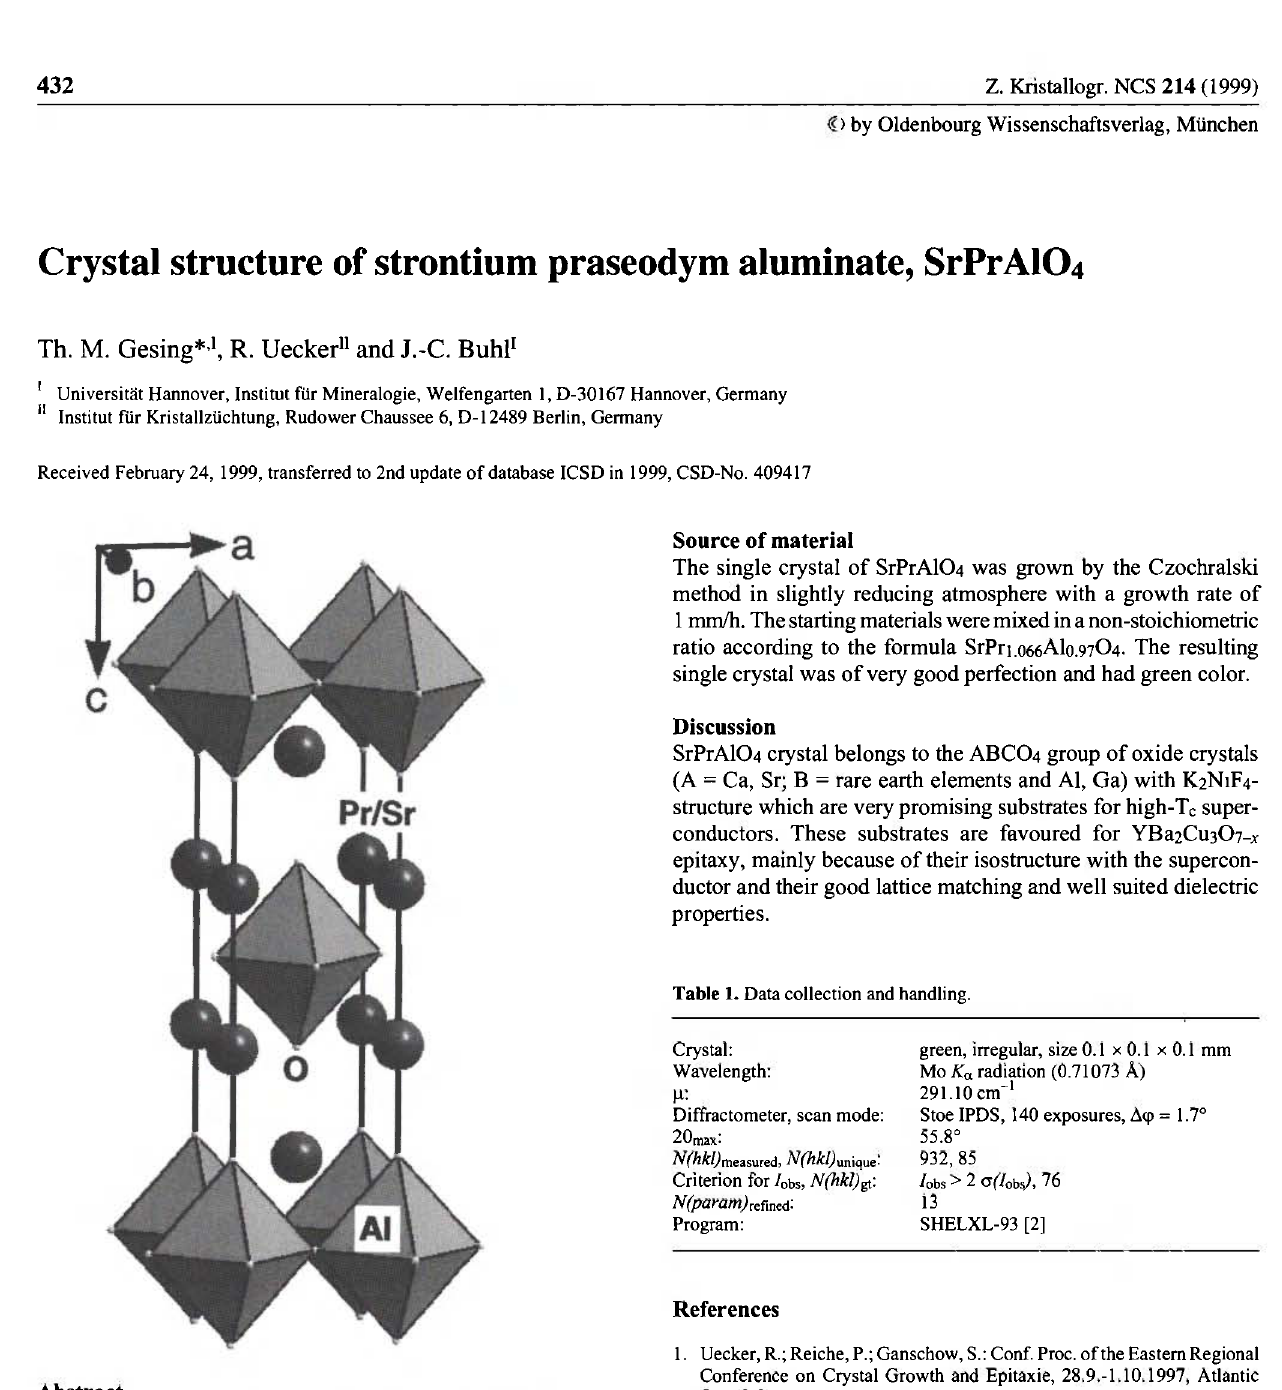
Table 2. Atomic coordinates and displacement parameters (in Ä